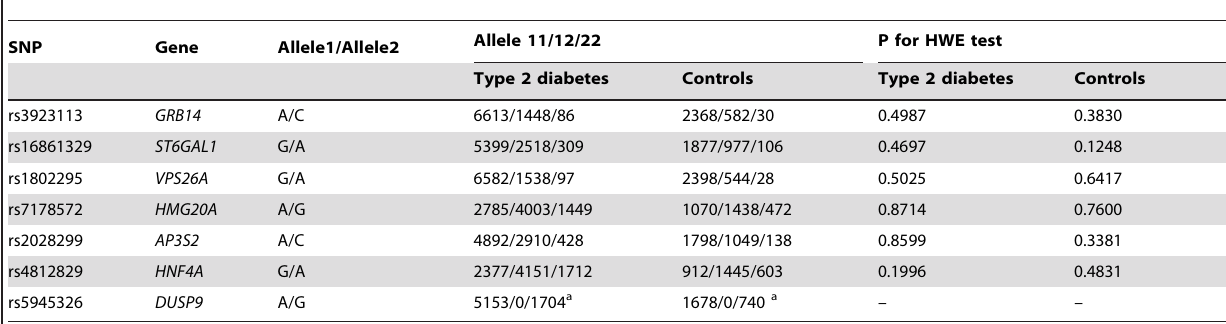
Table 2. Genotype distributions for 7 SNPs in case and control groups.